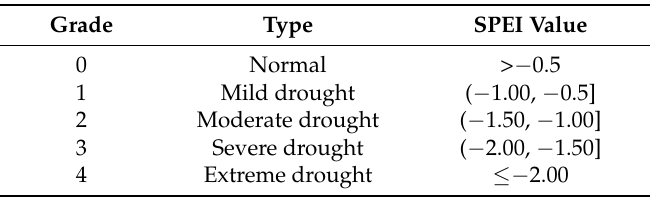
Table 1. The SPEI grade standard divided for